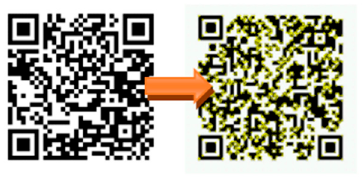
Figure 5. A self-made Vuforia marker.